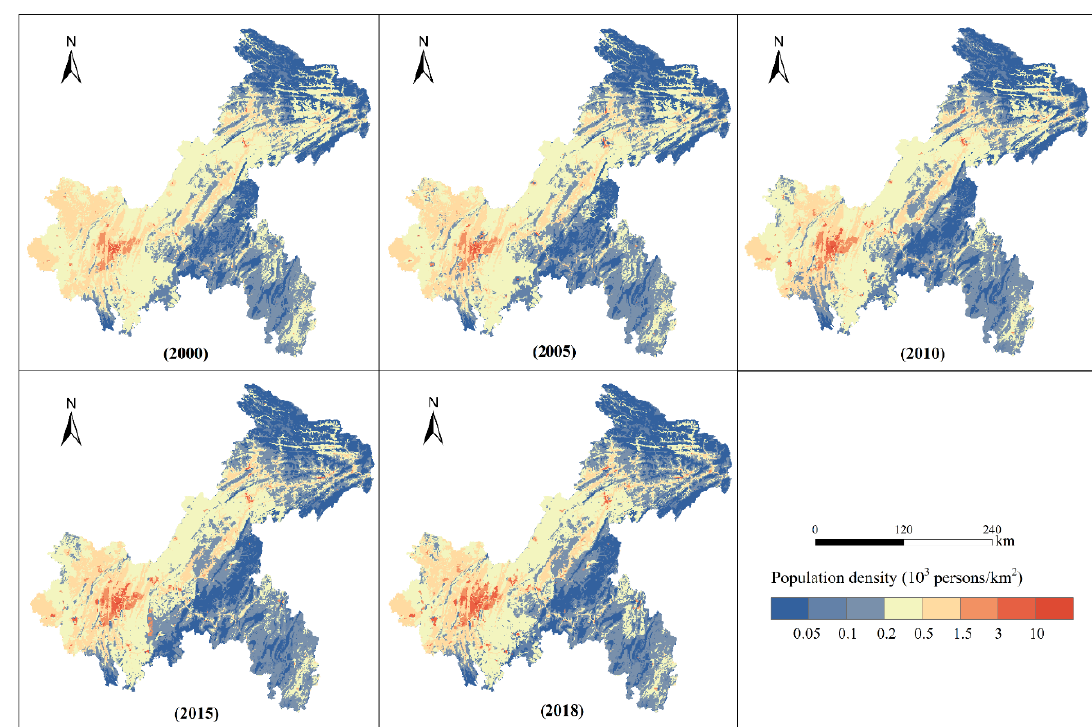
Figure 6. Simulated results of population density in Chongqing in 2000, 2005, 2010, 2015 and 2018. Low-density regions in Chongqing grew from 35.64 × 10 3 km 2 in 2000 to 41.07 × 10 3 km 2 in 2018 (an increase of 15.22%) (Table 5). 95% of the newly added regions were created by the loss of population from Intermediate-density regions, mainly in the northeast and southeast, including Fengjie, Yunyang, Wushan, Wuxi, Xiushan, Fengdu and Shizhu(Fig- ure 7). Table 5. Changes in population density from 2000 to 2018.